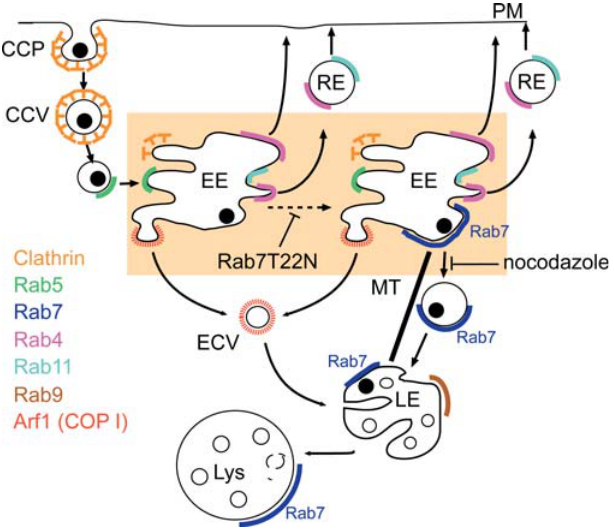
Figure 8. Schematic Representation of the SFV Transport Pathway from the Plasma Membrane to Lysosomes After uncoating of clathrin, the primary endocytic vesicles deliver the virus to Rab5-positive early endosomes, which contain Rab5 and Arf1 domains but do not contain Rab7. Rab7 is then recruited to these endosomes, and it forms additional domains (blue) that exclude the other early endosome-associated small GTPases. The virus moves into the Rab7 domain, and when this domain leaves the endosome as a Rab7- containing transport vesicle, the virus also leaves the Rab5-positive organelle. The Rab7-containing carrier moves along microtubules and fuses with other carriers or late endosomes. Also shown is an alternative route from the early to the late endosome, involving Arf1 and the ECV, which is not used by SFV. CCP, clathrin-coated pit; CCV, clathrin-coated vesicle; EE, early endosome; MT, microtubule; RE, recycling endosome; LE, late endosome; Lys, lysosome. DOI: